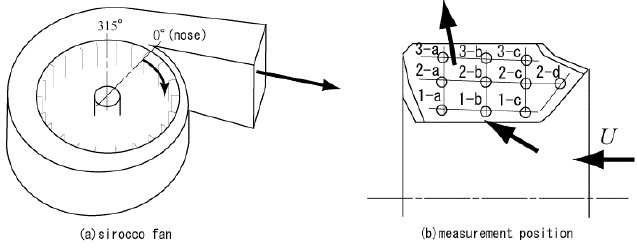
Fig. 6 Sirocco fan and measurement positions on the